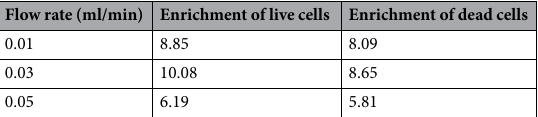
Table 1. Enrichment factor of live and dead cells at different flow